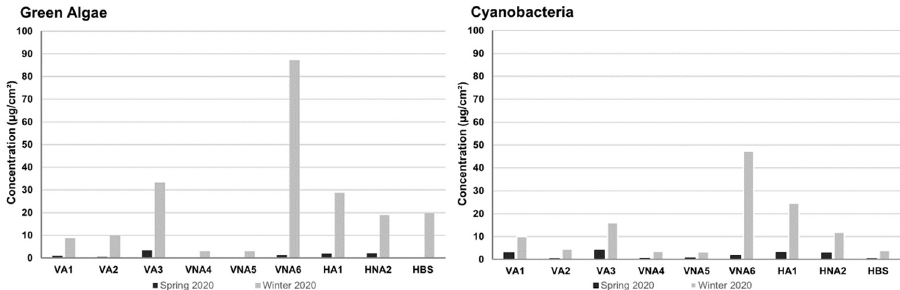
Fig 5. Cumulative microorganism concentrations (green algae and cyanobacteria) for different measurement areas and seasons: Spring and fall-winter. (Sum of each concentration by day of measurement). HBP is not presented because measurements were realized only during the spring season.